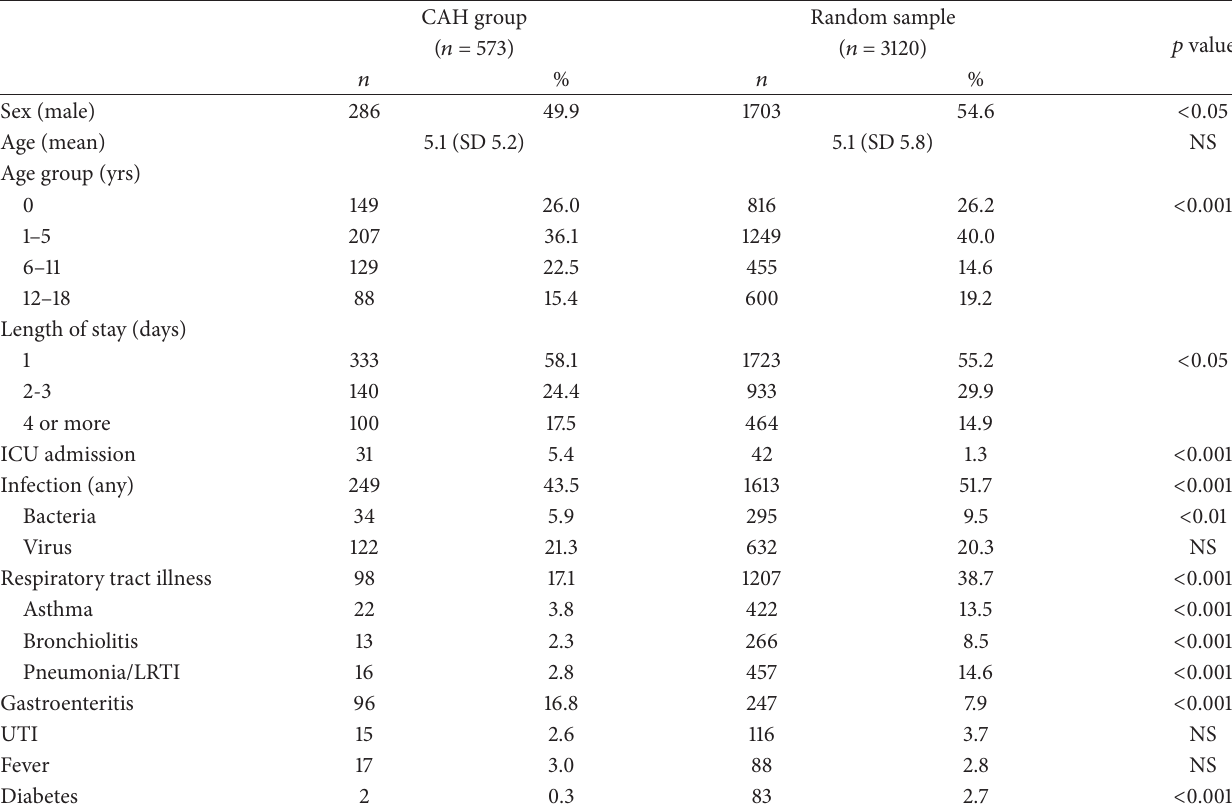
Table 1: Demographic and disease characteristics of patients in the CAH and random sample groups, NSW, 2001–2013. CAH group Random